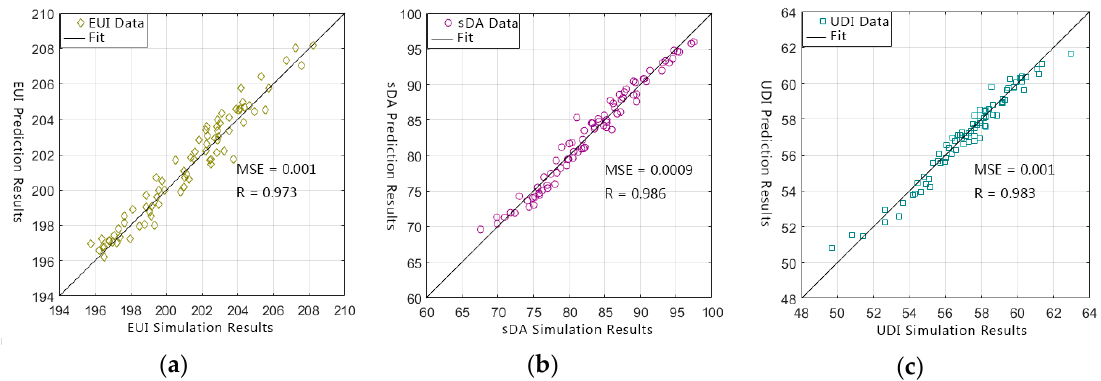
Figure 10. Regression between ANN prediction results and EnergyPlus simulation results: ( a ) regression between Energy Use Intensity (EUI) prediction and simulation results; ( b ) regression between Spatial Daylight Autonomy (sDA) prediction and simulation results and ( c ) regression between Useful Daylight Illuminance (UDI) prediction and simulation results.